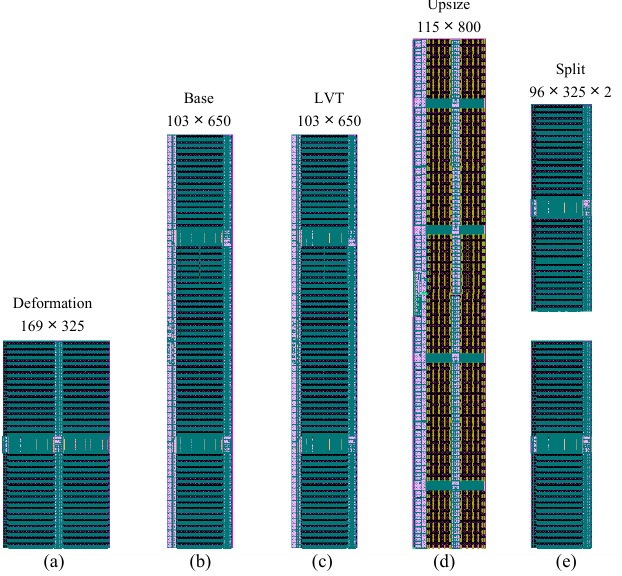
Figure 2. The multi-configuration of memory compilation.